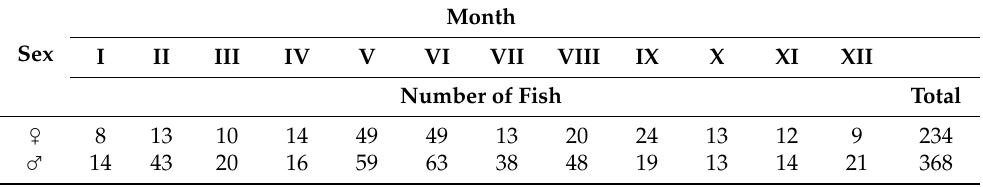
Table 1. The number of individuals of stone moroko, Pseudorasbora parva , used in the study.